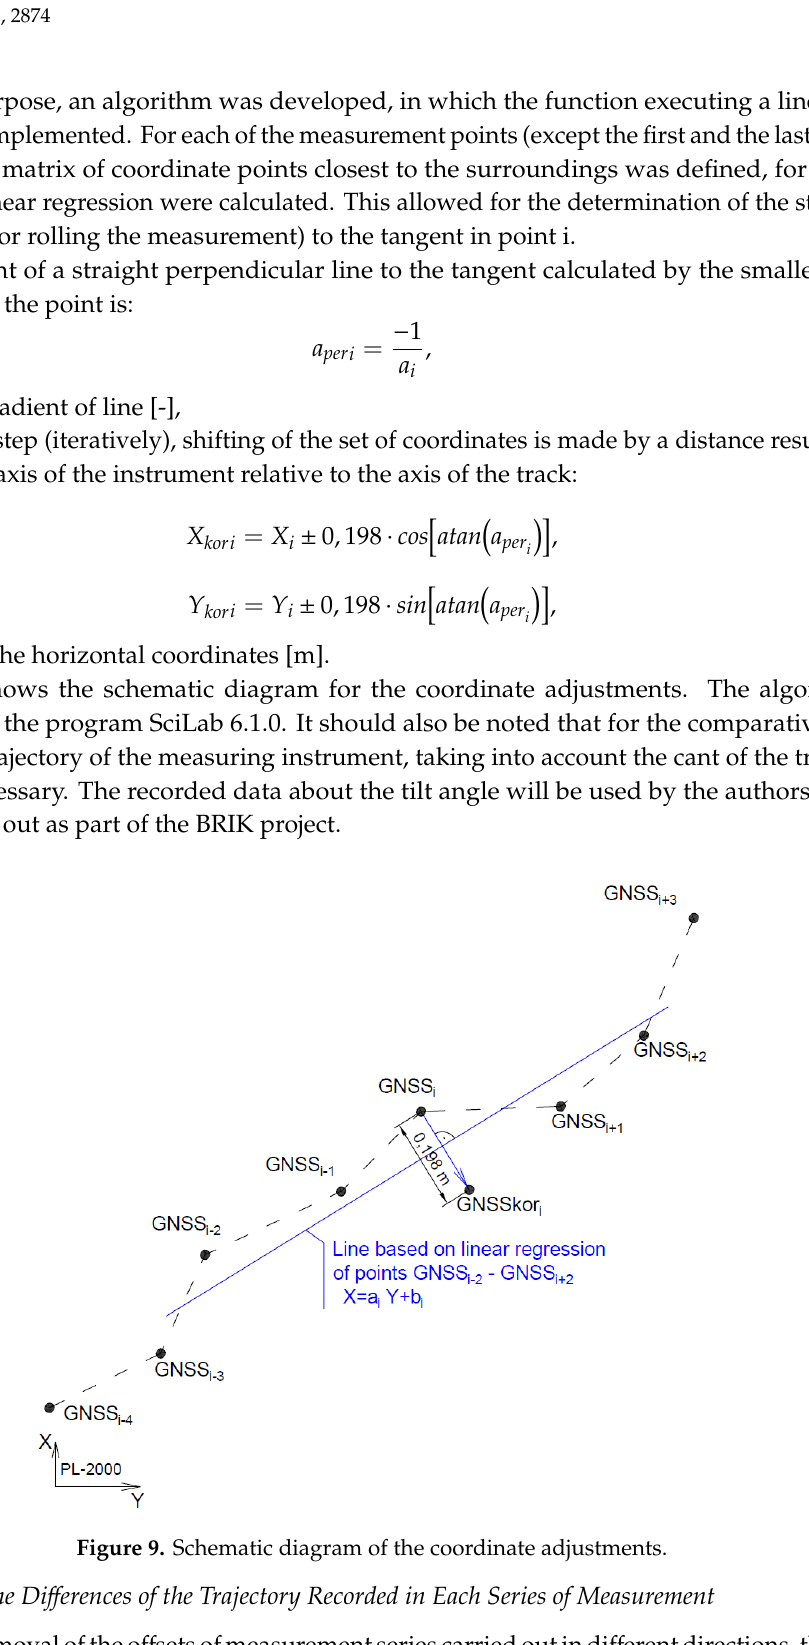
Figure 10. Schematic diagram of the calculation of horizontal absolute residuals between the results of tacheometric measurement and GNSS. The algorithm for calculating the residuals can be presented in the following steps: 